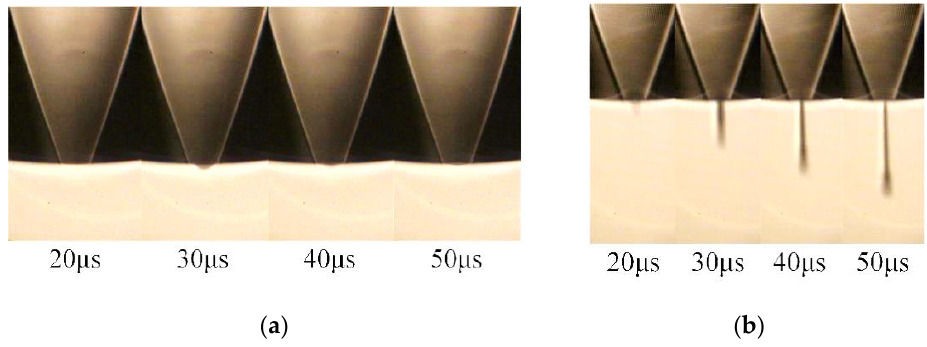
Figure 17. Results of the first set: ( a ) the t r is 1 µs ( b ) the t r is 10 µs. When the t r is 1 µs, fluctuation in the meniscus at the nozzle occurs during 20 to 50 µs. According to the analysis of the numerical simulation, when the t r is short, negative pressure at the nozzle is large, resulting in excessive ink being sucked into the nozzle. When the positive pressure wave reaches the nozzle, it causes fluctuations in the menis- cus, so no droplet is generated. When the t r is 10 µs, droplets with a long droplet tail are generated at the nozzle. This is because when the t r is long, negative pressure at the nozzle is small, resulting in a small amount of ink being sucked into the nozzle. When the positive pressure wave reaches the nozzle, it is easy for the printhead to generate droplets, thus forming a long droplet tail, which is not good for controlling the shape and size of the droplets. In the second set, the effect of different t f on droplet morphology is observed. The t r , t d , and U are set according to the optimized parameters determined by simulation ( t r = 5 µs, t d = 10 µs, U = 40 V), and the actuating frequency is 1 kHz, setting t f to 1 µs and 5 µs, respectively. The experimental results are shown in Figure 18.